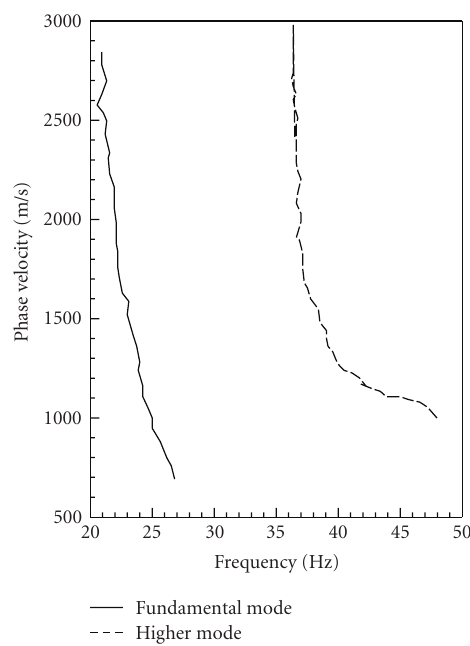
Figure 12: Comparison between shear wave velocity values of MASW results (initial multilayer model) and borehole data for the GSC Anderson Road site (NRCan site).